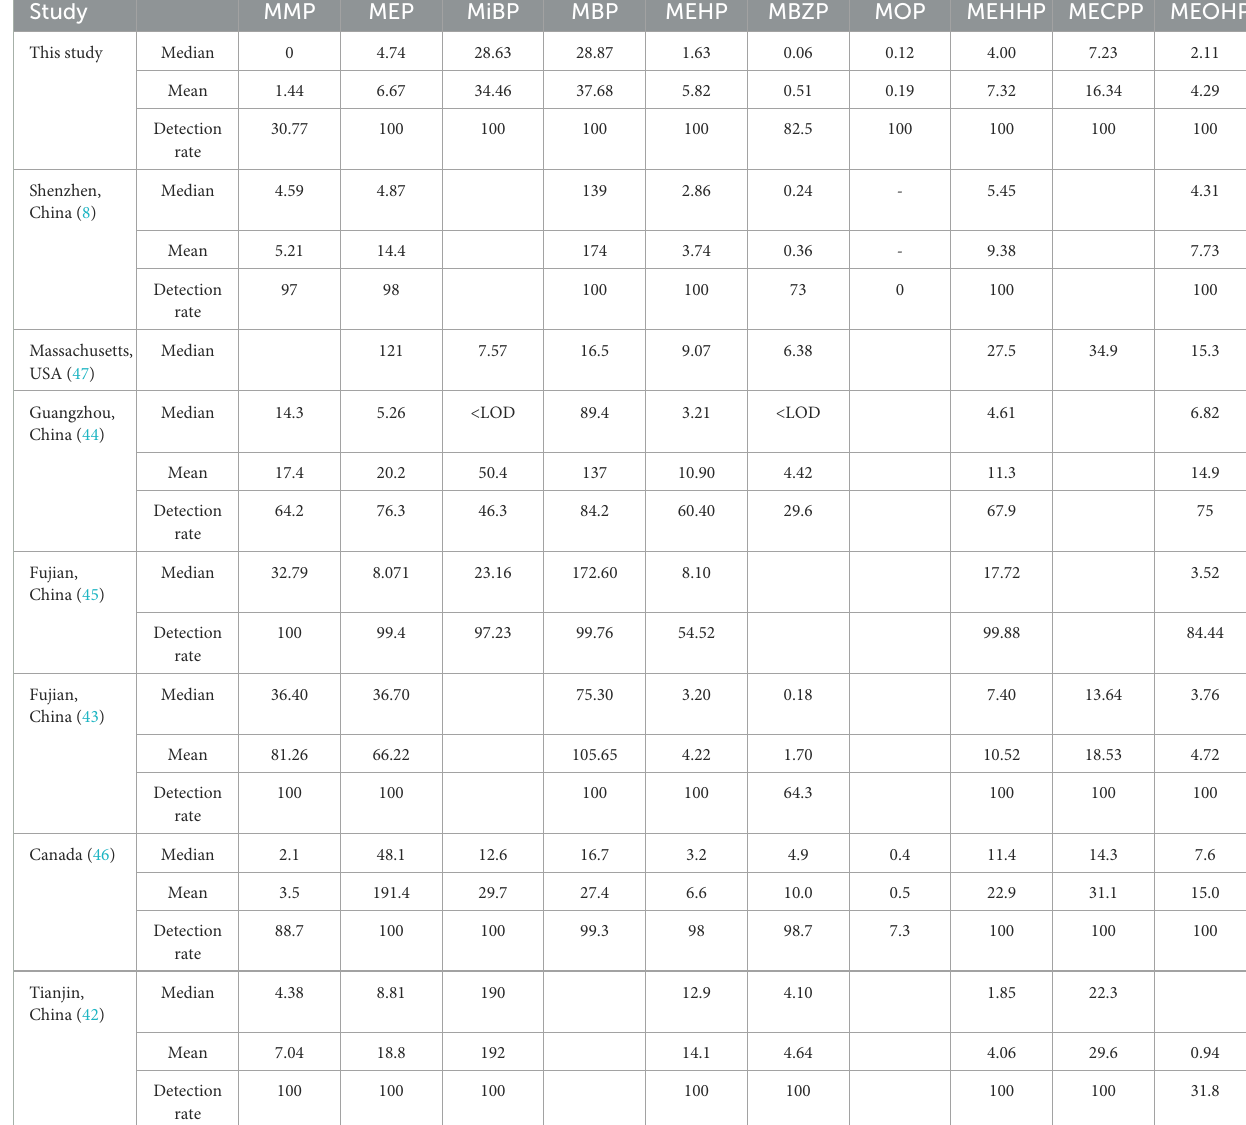
TABLE 8 Comparison of concentrations and levels of mPAEs in this study and previous studies